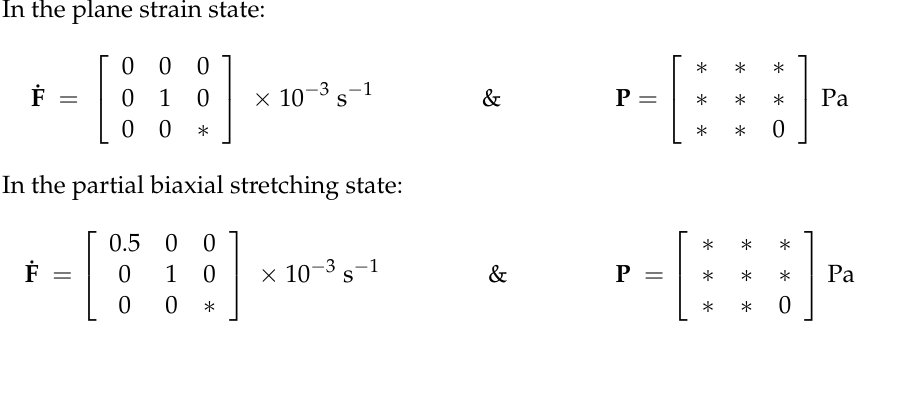
Figure 3. Projected loading states to conclude the forming limit diagram.